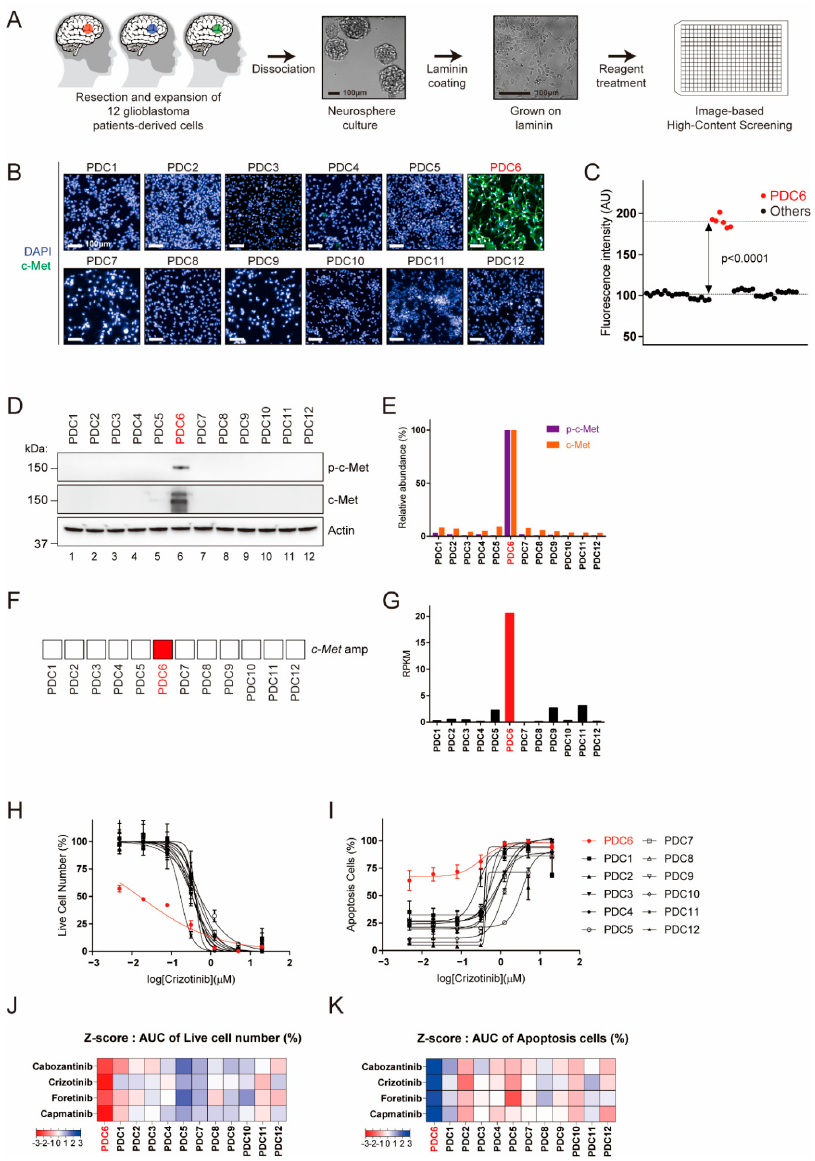
Figure 1. Identification of c-Met (tyrosine-protein kinase Met)-overexpressed patient-derived glioblastoma tumor cells by image-based high-content screening. ( A ) Schematic representation of glioblastoma patient-derived cell preparation and image-based high-content screening. Twelve patient- derived glioblastoma tumor specimens were resected, dissociated, and grown as neuro-sphere. The cells grown on laminin-coated plates were subjected to drug screening and